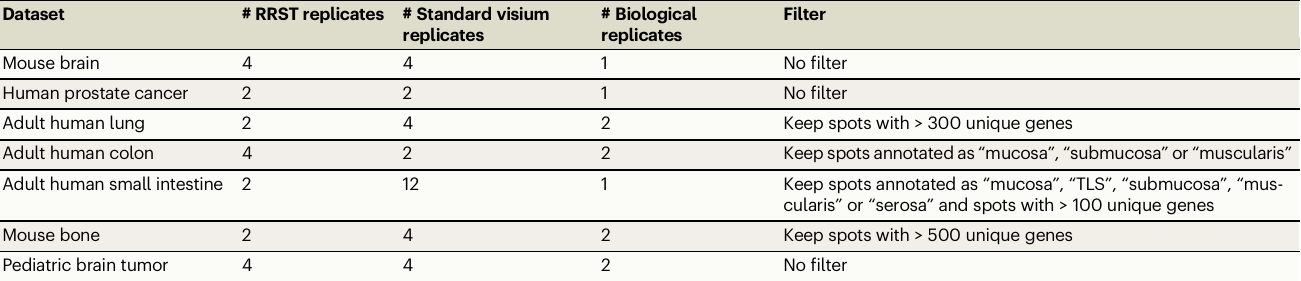
Table 1 | Overview of spatially resolved transcriptomics samples and fi ltering settings used in pre-processing steps